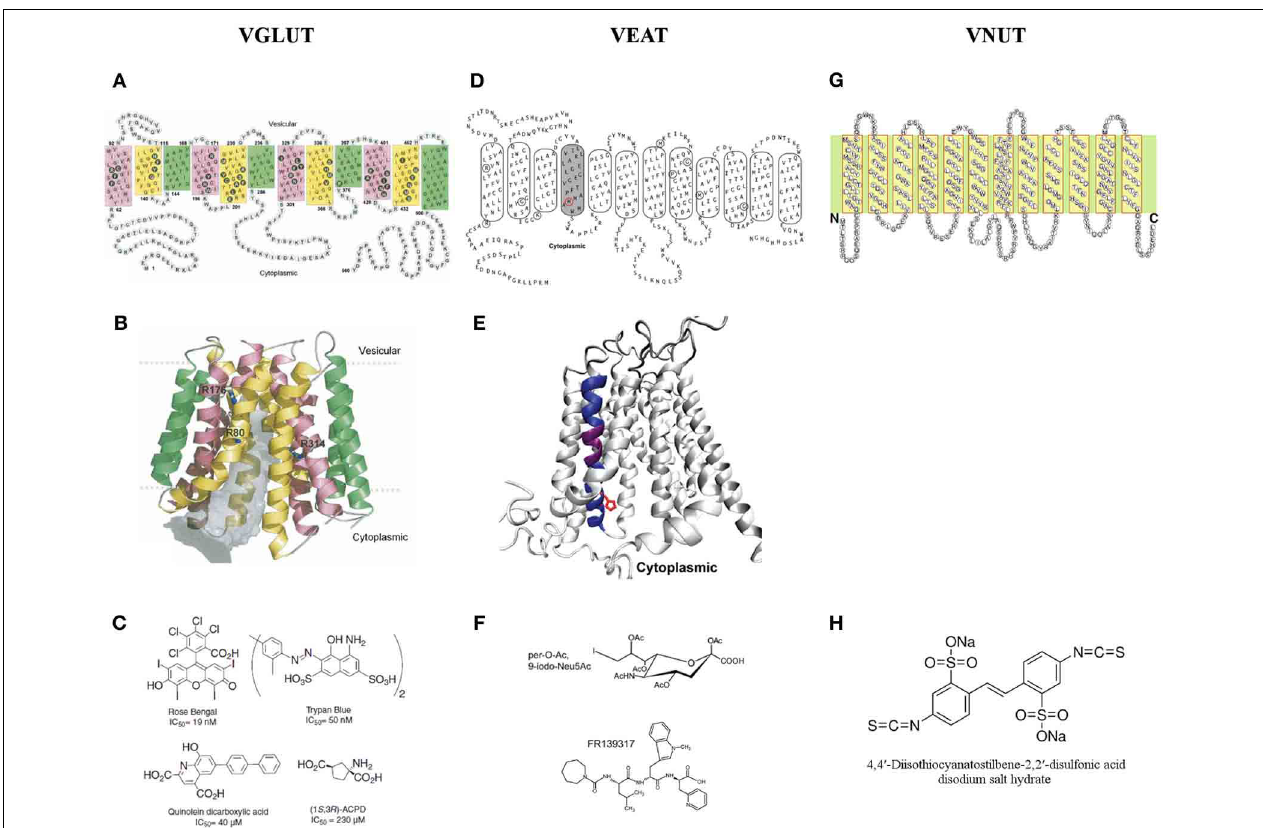
FIGURE 3 | A two and three dimensional molecular structure of the members of the SLC17 family. (A,B) The vesicular glutamate transporter 1 (VGLUT1) (Almqvist et al., 2007), (D,E) the vesicular excitatory amino acid transporter (VEAT) (Courville et al., 2010) and (G) the vesicular nucleotide transporter (VNUT) (Sawada et al., 2008). (C) The different families of VGLUT